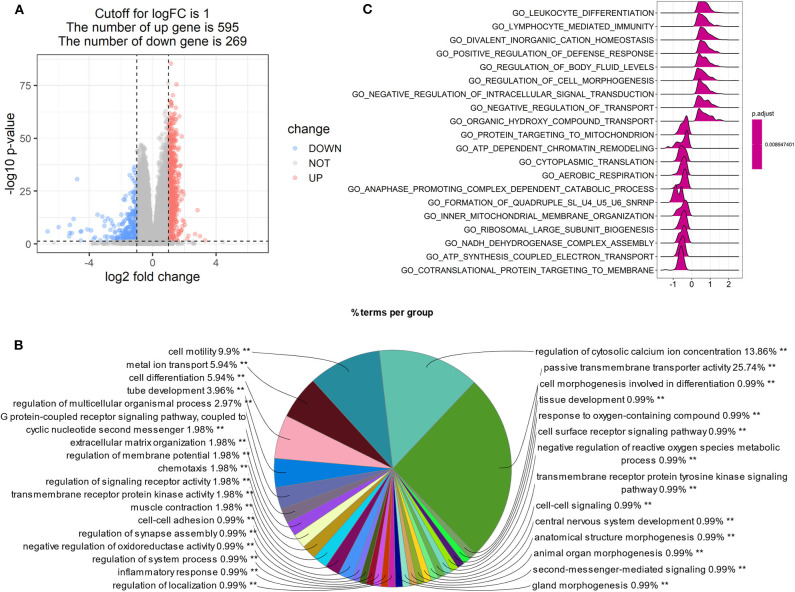
Gene Ontology (GO) and Gene Set Enrichment Analysis (GSEA) of tumor samples with high expression of lysophosphatidic acid receptor 1 (LPAR1) vs. those with low expression of LPAR1. The analysis was based on the biological process category in GO. (A) Volcano plot showing the differentially expressed genes (DEGs) comparing tumor samples between samples with high LPAR1 expression and samples with low LPAR1 expression. (B) The pie plot only showed the pathways with p-value < 0.01 and the GO term network connectivity score is 0.6. The upregulated DEGs were enriched in a set of pathways, including passive transmembrane transporter activity, cell motility, metal ion transport, cell differentiation, tube development, and G protein-coupled receptor signaling pathway. (C) The plot shows the top 20 categories with p-value < 0.05 via GSEA, including leukocyte differentiation, lymphocyte-mediated immunity, divalent inorganic cation homeostasis, positive regulation of defense response, regulation of body fluid levels, regulation of cell morphogenesis, and so on.